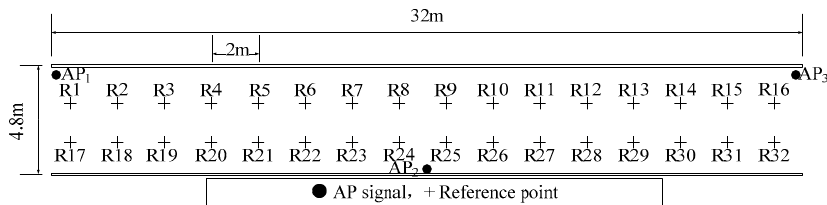
Figure 6. KJJ660W. Figure 6. KJJ660W.